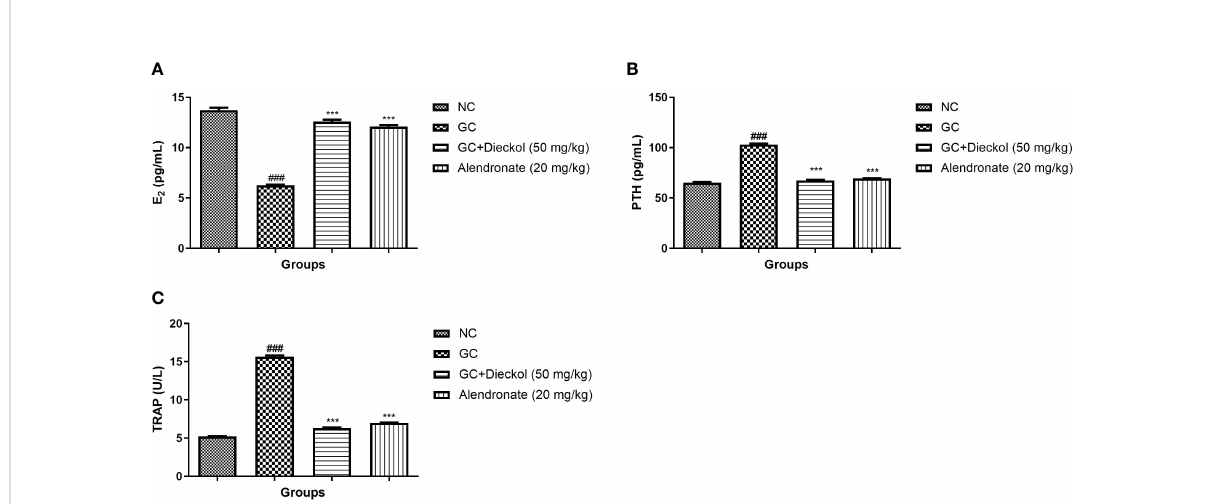
FIGURE 4 Dieckol inhibited glucocorticoid-induced osteoporosis in rats by increasing levels of estradiol, PTH, and TRAP. (A) E 2 , (B) PTH, and (C) TRAP. Results are shown as means ± SEM (n = 12). ***P < 0.001 when contrasted with the disease group and the normal group.